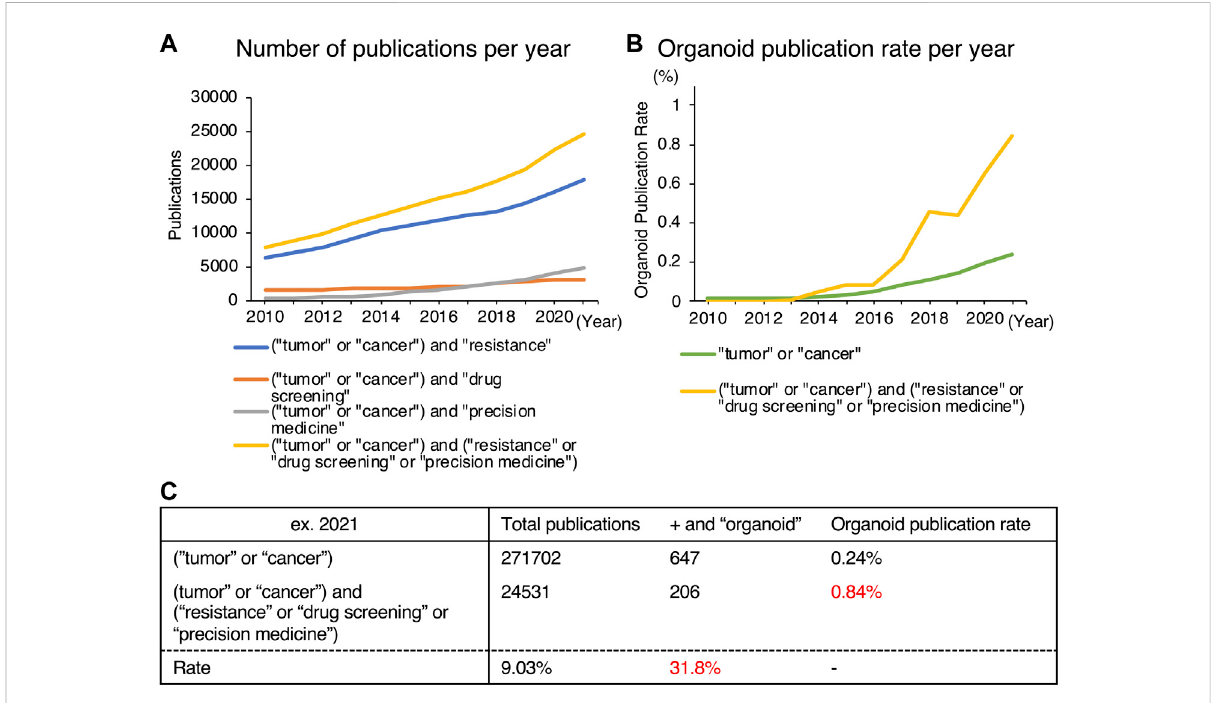
FIGURE 1 Trends in publications on organoids obtained from a PubMed search. (A) Number of publications in speci fi c areas [resistance (blue), drug screening (orange), precision medicine (grey), or all (yellow)] in cancer-related articles. (B) Proportion of organoid-related publications in cancer research (green) and in anticancer drug-related areas (yellow). (C) Detailed data of (B)